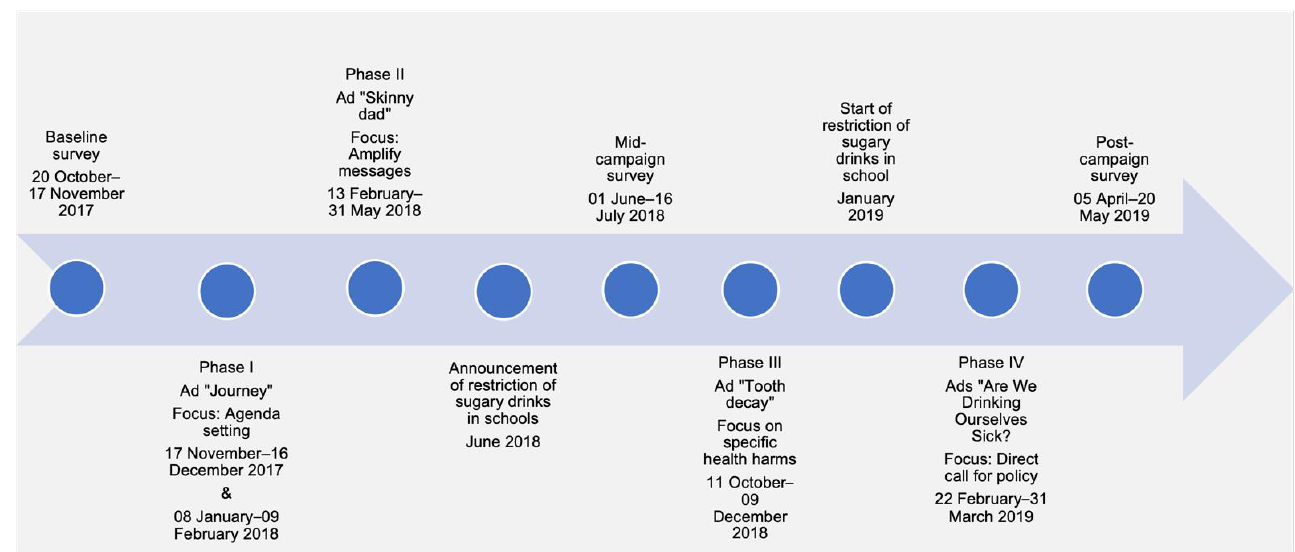
Figure 2. Billboard in St. Andrew, Jamaica, 2019 —“Are We Drinking Ourselves Sick?” (Phase IV).